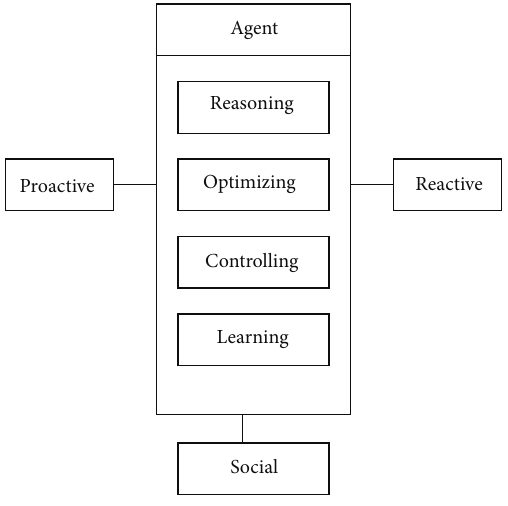
Figure 2: Functionality of an